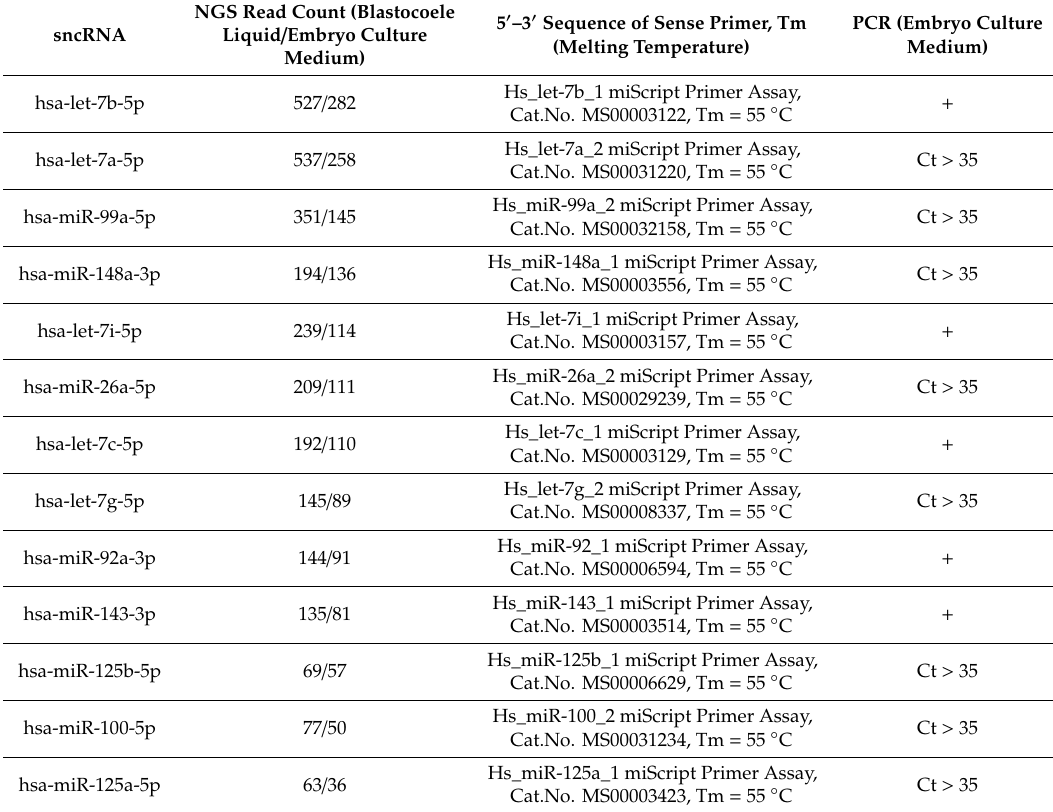
Table 1. Small non-coding RNA (sncRNA) identification by next generation sequencing (NGS) and real time polymerase chain reaction (PCR) (if Ct > 35 cycles in most of the studied samples, these data were excluded from the analysis, “ + ”—data suitable for